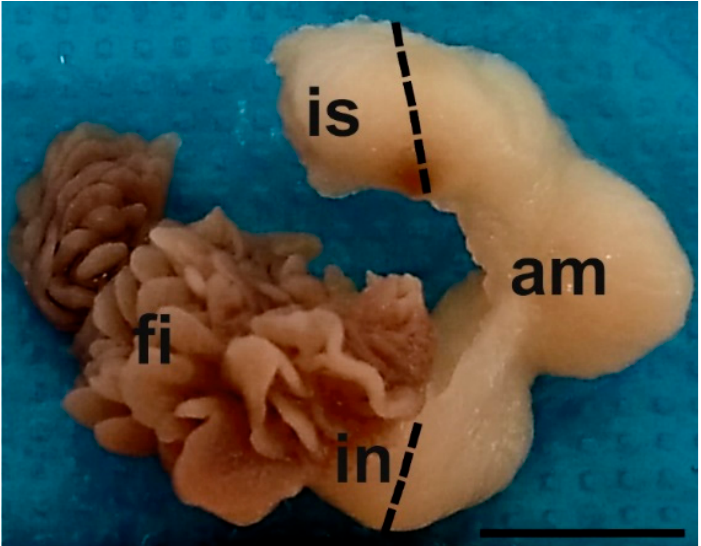
Figure 1. Gross anatomy of the baboon Papio hamadryas oviduct. Key: am, ampulla; fi, fimbriae; in, infundibulum; is, isthmus. Scale bar = 0.5